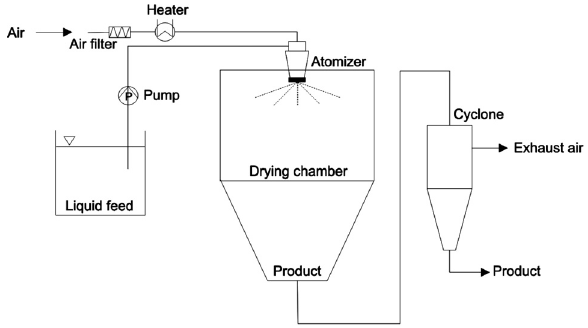
Figure 1. – Spray drying process Process parameters were kept constant for all fruit concentrates and are presented in Table